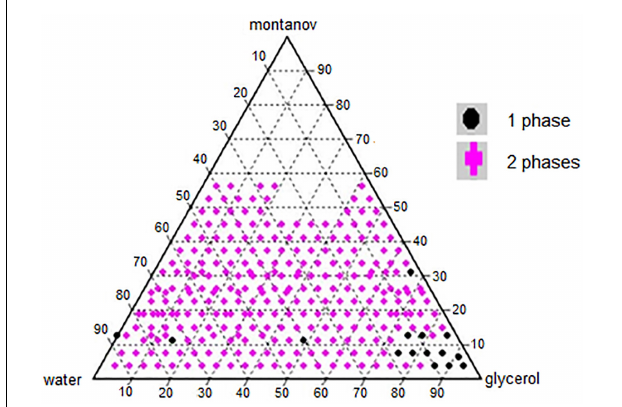
FIGURE 1 | Ternary compositions of surfactant, co-solvent (glycerol), and double distilled water.